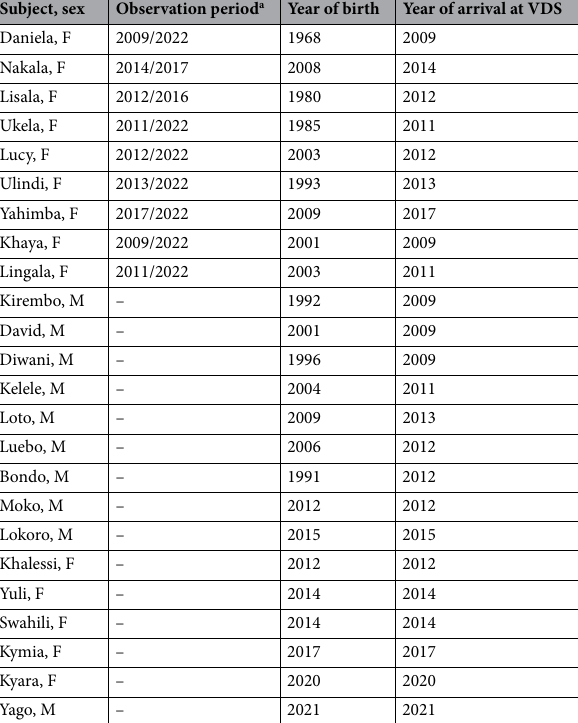
Table 1. Bonobo females involved in the study and individuals belonging to the La Vallée des Singes group. a Only for the females involved in the analyses.